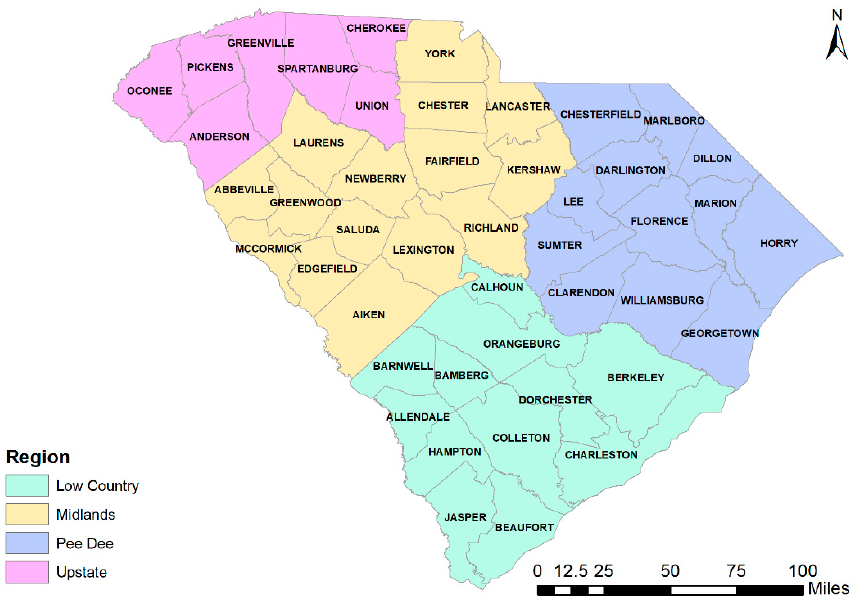
Figure 1. Responses were grouped into four regions based on the county in which their largest affected property was.